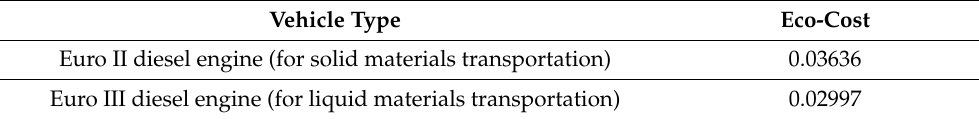
Table A2. Ecocosts associated with transportation per vehicle type (USD km − 1 Vehicle − 1